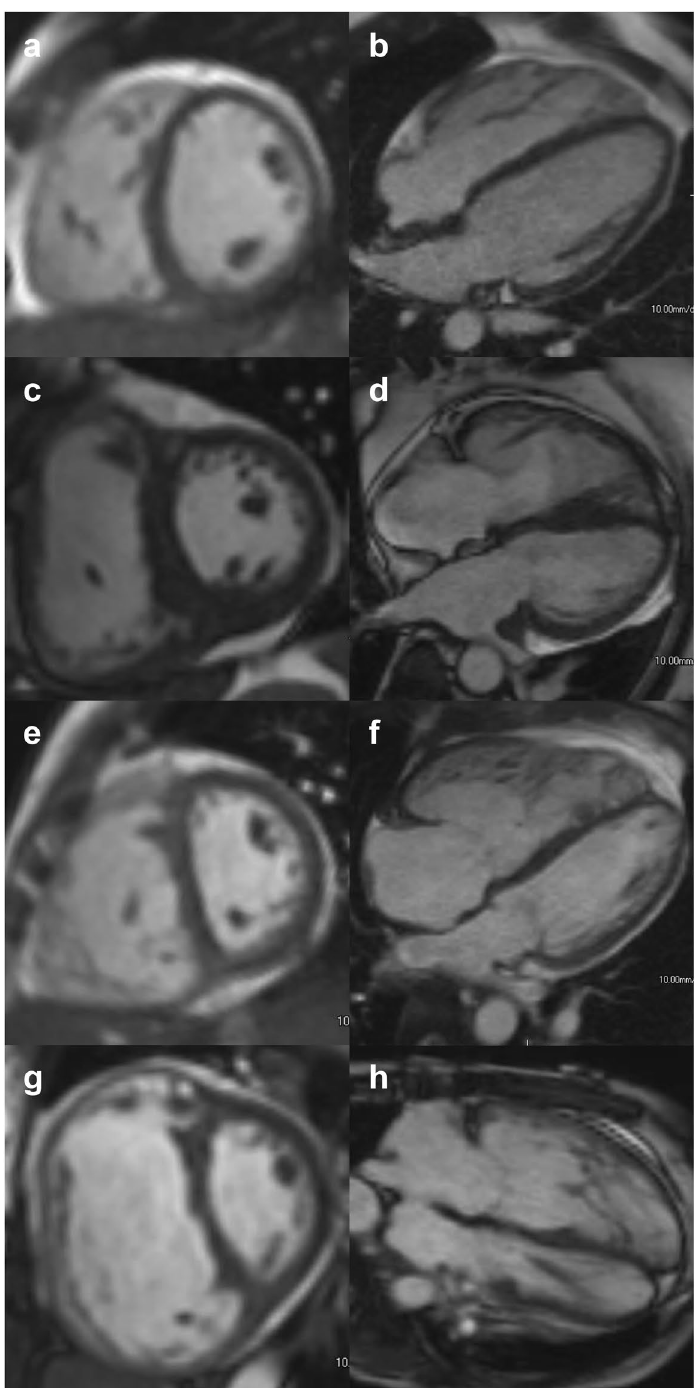
Figure 1. Examples of RV/LV volume ratio categories. ( a , b ) Short-axis (SAX) and 4-chamber views of a patient with a normal sized RV RV/LV volume ratio = 1.20); ( c , d ) SAX and 4-chamber views of a patient mildly dilated RV (RV/LV volume ratio = 1.50); ( e , f ) SAX and 4-chamber views of a patient with moderately dilated RV (RV/LV volume ratio = 1.70); ( g , h ) SAX and 4-chamber view of a patient with severely dilated RV (RV/LV volume ratio =